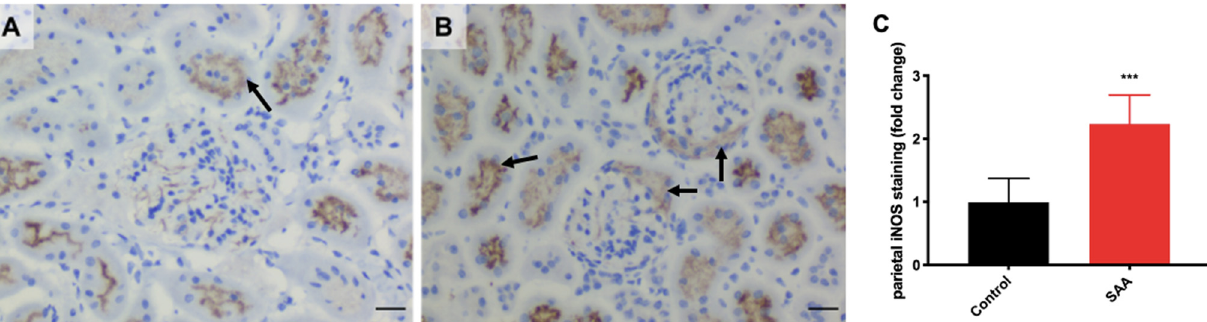
Figure 8. SAA administration stimulates iNOS expression in the renal cortical tissue. Male ApoE − / − mice were randomly allocated to ( A ) the vehicle control group (administered 100 µL PBS every 3 days for 2 weeks) and ( B ) the SAA group (administered 12 µg SAA protein every 3 days for 2 weeks). Kidney tissue was harvested 4 weeks after cessation of treatment and fixed in situ before embedding and sectioning (5 µm). Renal sections were dewaxed then rehydrated before undergoing heat-induced antigen retrieval. iNOS expression was assessed using immunohistochemistry and light microscopy. Slides were visualised using an Axio Scope.A1 light microscope at 40× magnification (scale bar = 20 µm); images are representative of at least 4 fields of view for each sample. For all images shown, nuclei are stained with haematoxylin (appearing as blue), and iNOS with DAB (appearing as brown). Black arrows indicate iNOS+ immunostaining (DAB positive) localised to epithelial cell brush borders and to the parietal epithelial cells lining the inner surface of Bowman’s space in the SAA group. Representative images show iNOS+ immunostaining in renal cortical fields from n = 5 (control), n = 6 (SAA). ( C ) Parietal iNOS+ staining within the glomeruli was quantified using mean grey value and an optical density calculation for each field of view and averaged for each sample. Data shown as relative mean ± SD. *** Different to the control group; p < 0.0001.